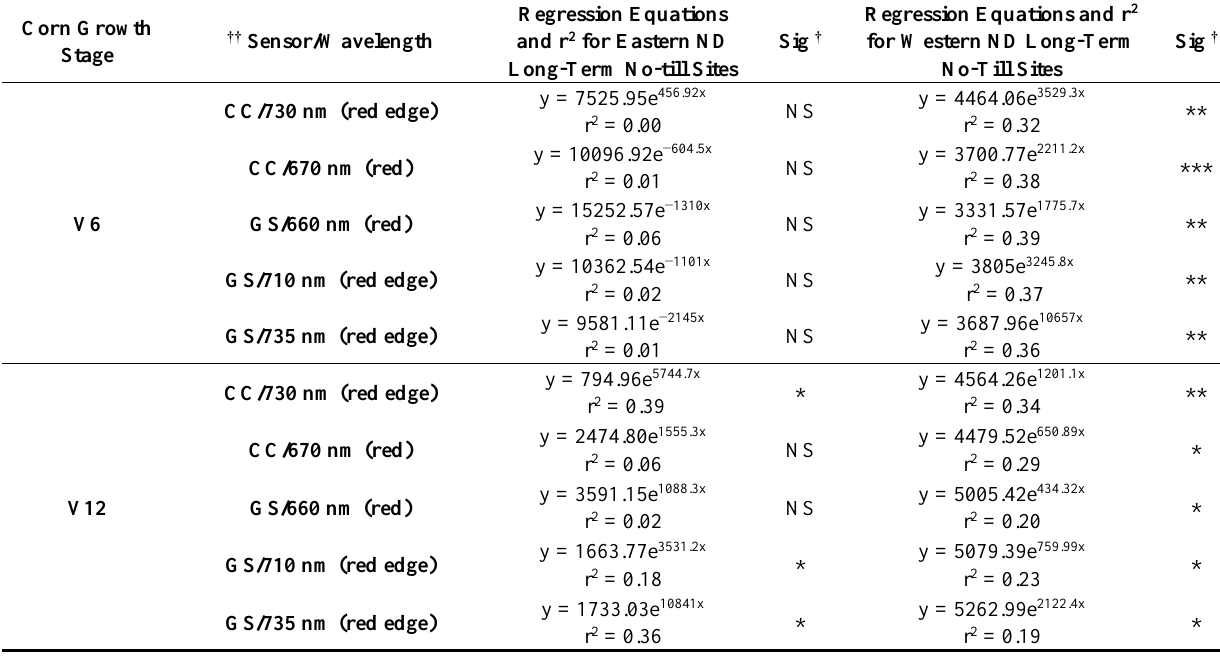
Table 5. Exponential regression equations of Yield and INSEY from five wavelengths of two ground-based active-optical sensors in eastern North Dakota ( n = 47) and western North Dakota no-till ( n = 95) systems at V6 and V12 growth stages of corn. Regression Equations and r 2 for Eastern